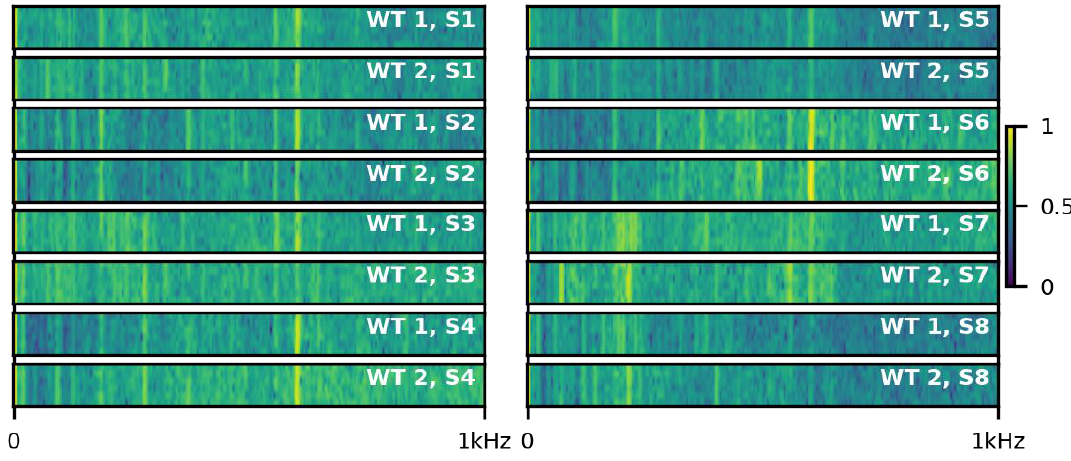
Figure 4. Sample spectrograms of WT1 and WT2, converted from the measurements of components monitored by the accelerometers S1–S8. The figure shows one sample from each wind turbine and each accelerometer. All spectrogram segments run over 1 s of time (the vertical axis) and show normalized logarithmic amplitudes for frequencies up to 1000 Hz (horizontal axis).